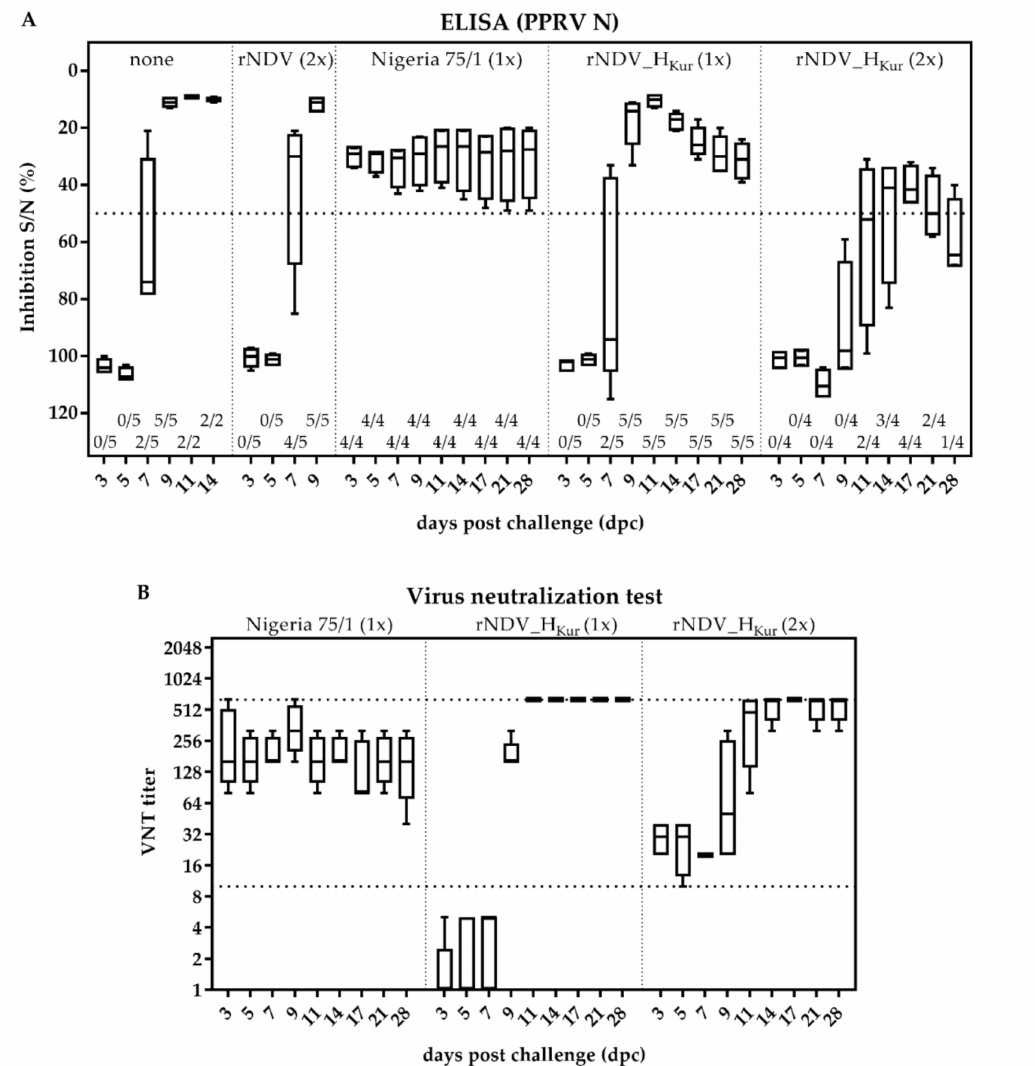
Figure 8. Serology after PPRV challenge infection. Five goats each were either left unvaccinated (group 1), double inoculated with rNDV (group 2), single vaccinated with PPRV Nigeria 75 / 1 (group 3), single vaccinated with rNDV_H Kur (group 4), or double vaccinated with rNDV_H Kur (group 5). All goats were infected with PPRV Kurdistan / 11 three weeks after immunization. ( A ) Sera were taken at indicated days after challenge infection (dpc) and analyzed for the presence of antibodies, specific to PPRV N, by competitive ELISA (cELISA). A dotted line indicates the respective thresholds. The number of seropositive tested samples, relating to the total number of tested samples, is given below the boxplots. ( B ) Sera from goats, vaccinated with Nigeria 75 / 1 or rNDV_H Kur , were tested for the presence of neutralizing antibodies against PPRV Nigeria 75 / 1 by virus neutralization test (VNT). Sera exhibiting a VNT-titer > 10 are considered seropositive (dotted line), sera can reach a maximum titer of 640, as they were not further titrated (dotted